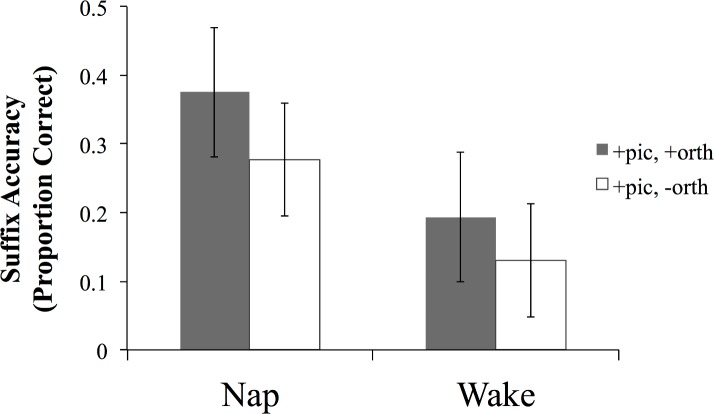
Proportion of correctly recalled suffixes in cued recall for the two groups for the conditions with and without the additional orthographic cue.Error bars represent 95% CIs.